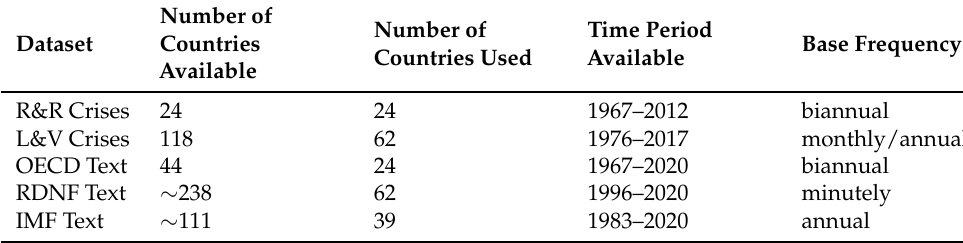
Table 1. Summary statistics of data sources.